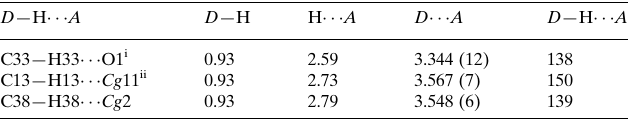
Hydrogen-bond geometry (A˚ , (cid:2)